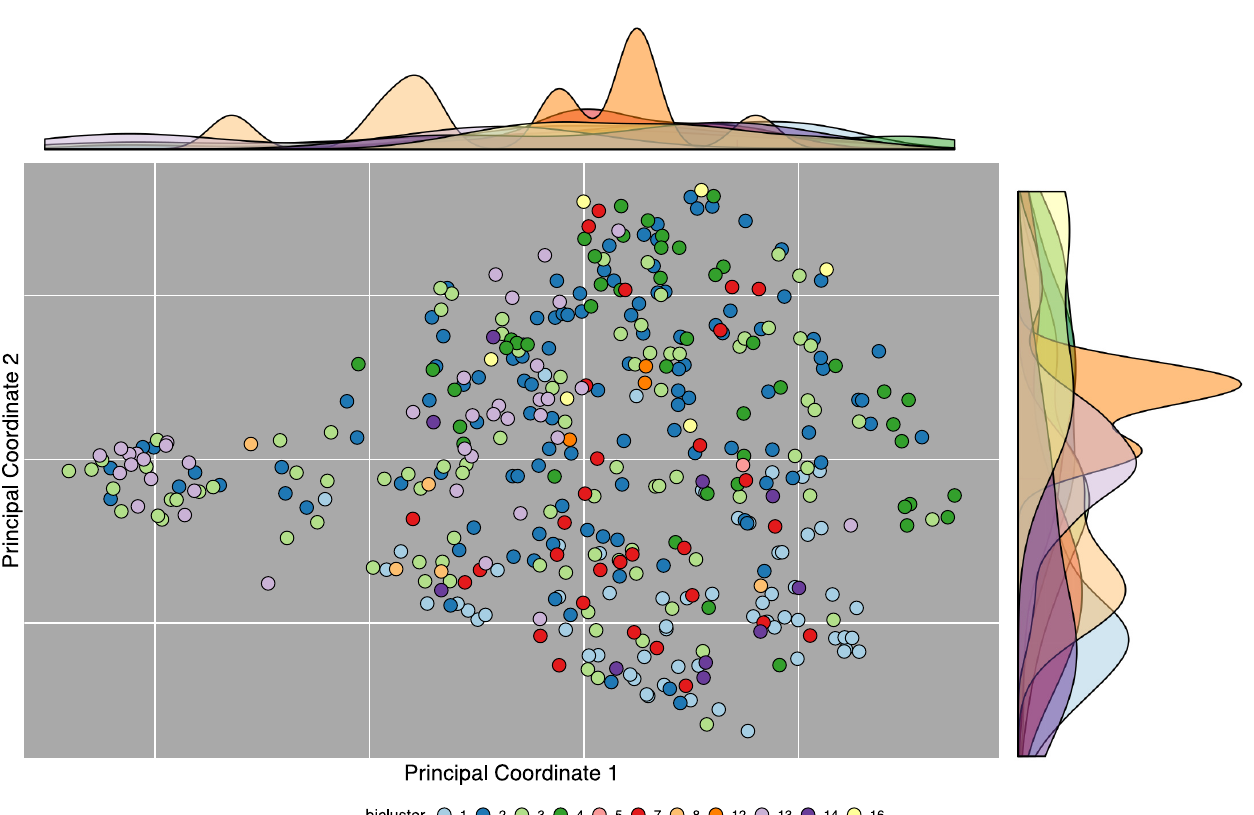
Fig 9. Bicluster (color) vs compound structure (position). Multidimensionalscaling (MDS) was used to embedsmall moleculesinto a two dimensional space (x- and y-axis). Each point representsan FDA approveddrug. A density map coloredby each bicluster is shownfor the MDS principalcoordinate 1 (on top) and principalcoordinate2 (on right). The distancebetweenthe points is proportional to the chemical similarity betweenthe two compounds.Bioactivity-based biclustering results are also indicatedby colors, with each compoundassignedto its lowest numbered (densest and/or largest) bicluster. Only the 11 biclusterswith the largest numberof compoundsare shown, to allowfor a visuallydistinct color palette.